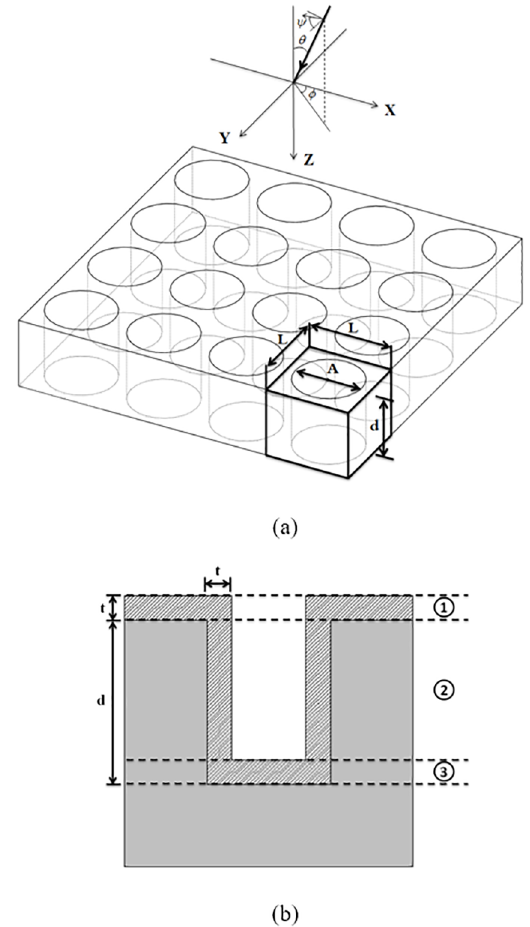
Figure 1. (a) Schematic diagram of PhC model for RCWA calculations (b) photonic crystals deposited with high step coverage ARC